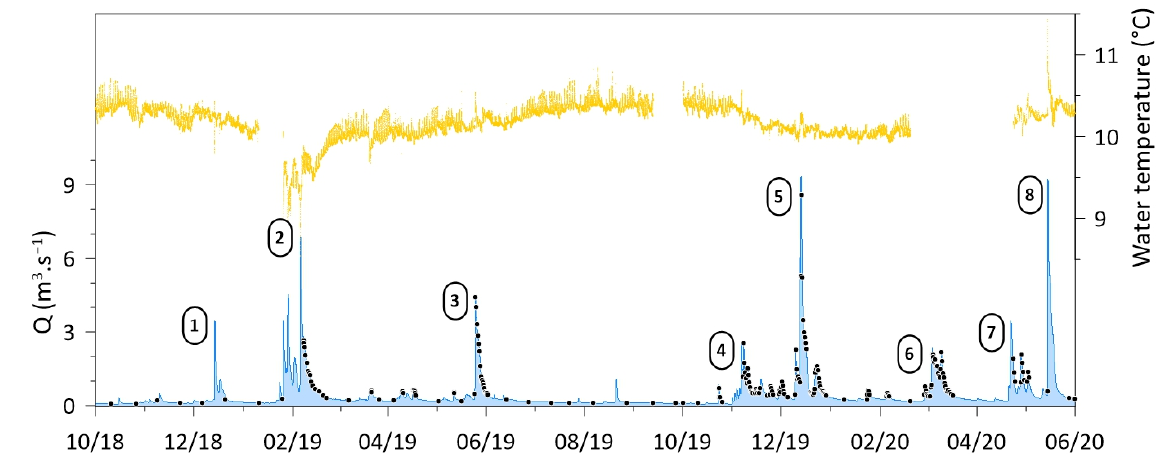
Figure 2. Temporal series of stream discharge (blue line), temperature (yellow line) and sampling periods (black points) for physicochemical analyses over 2 hydrological years, from October 2018 to May 2020. The numbers circled refer to the different major floods during the study period.